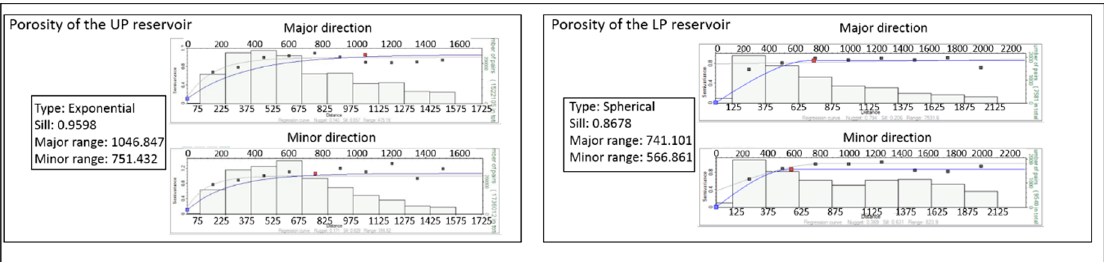
Figure 8. Variograms of the porosity of the “UP” and “LP” reservoirs.